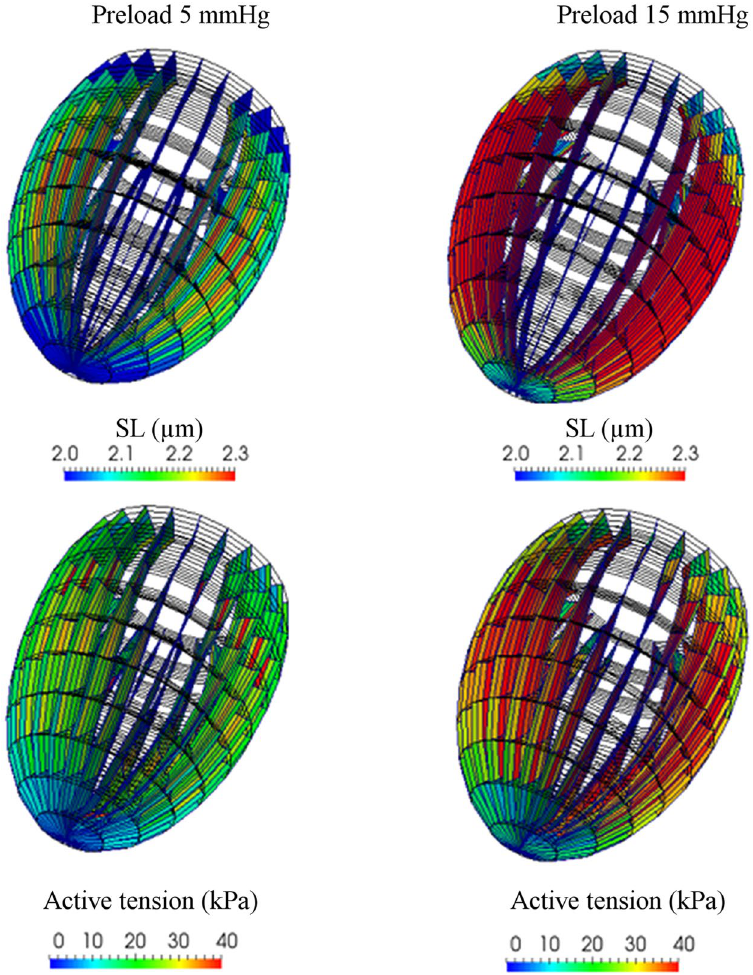
Figure 4. Ventricle model simulations: Sarcomere lengths in different finite elements at the end of the diastolic phase (upper part) and active tension at peak (lower part, at 0.1 s after the beginning of the systolic phase). Two preloads are shown, at 5 and 15 mmHg (left and right, respectively). The tension is higher at 15 mmHg because of the effects of titin on the mechanosensing